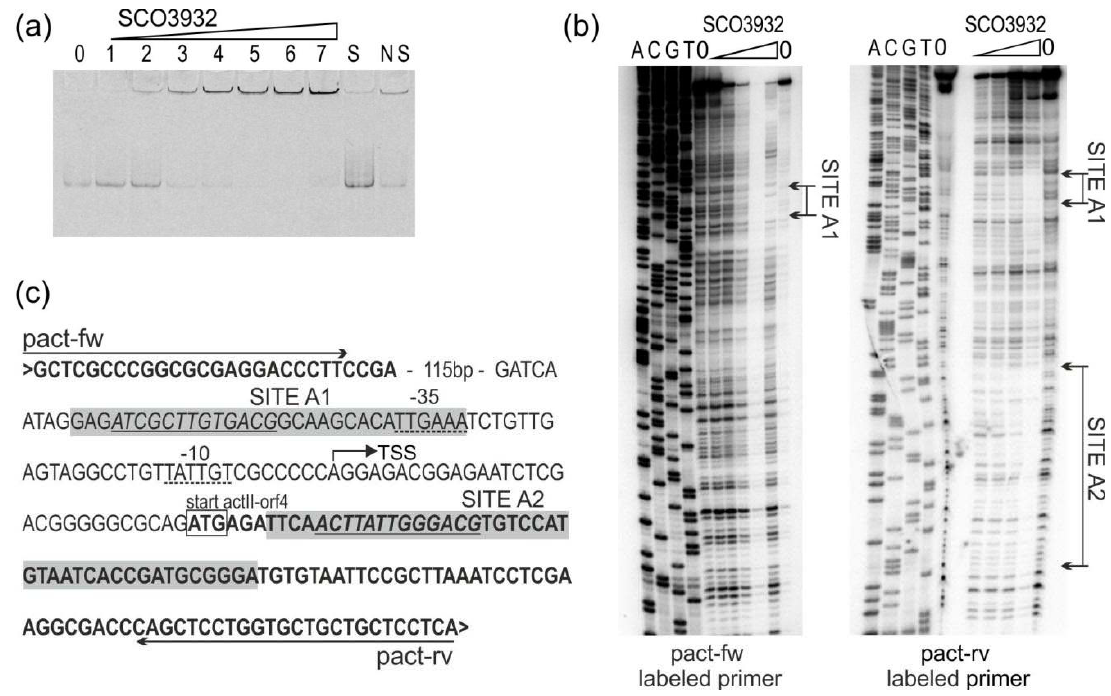
Figure 3. Binding of SCO3932 protein to the promoter region of actII ‐ orf4. ( a ) Electrophoretic mobility shift assay. Lanes 0–7 contain 0, 0.9, 1.8, 9.4, 18, 28, 47 and 94 nM SCO3932 protein, respectively. Lanes S and NS contain ten ‐ fold excess of the specific and nonspecific competitor DNA, respectively, and 94 nM SCO3932 protein; ( b ) DNase I footprinting of SCO3932 binding to the actII ‐ orf4 promoter region. The amounts of SCO3932 used were 0, 100, 200, 400, 800 1600, 0 nM. The regions protected from cleavage by DNase I are indicated (sites A1, A2). Lanes G, A, T, C correspond to the sequence ladder generated with the labelled primer. ( c ) DNA sequence of the actII ‐ orf4 promoter region. Primers are marked with horizontal arrows. Coding sequence is bold, translational start codon is marked with a box. Bent arrow denotes transcriptional start site (TSS) according to Jeong et al., 2016 [25]. The − 35 and − 10 regions are underlined with a dashed line. The sequences protected by SCO3932 from cleavage (sites A1, A2) are indicated by the shaded boxes. Sequence corresponding to the common motif identified by MEME (see Figure 4) is underlined and in italic.